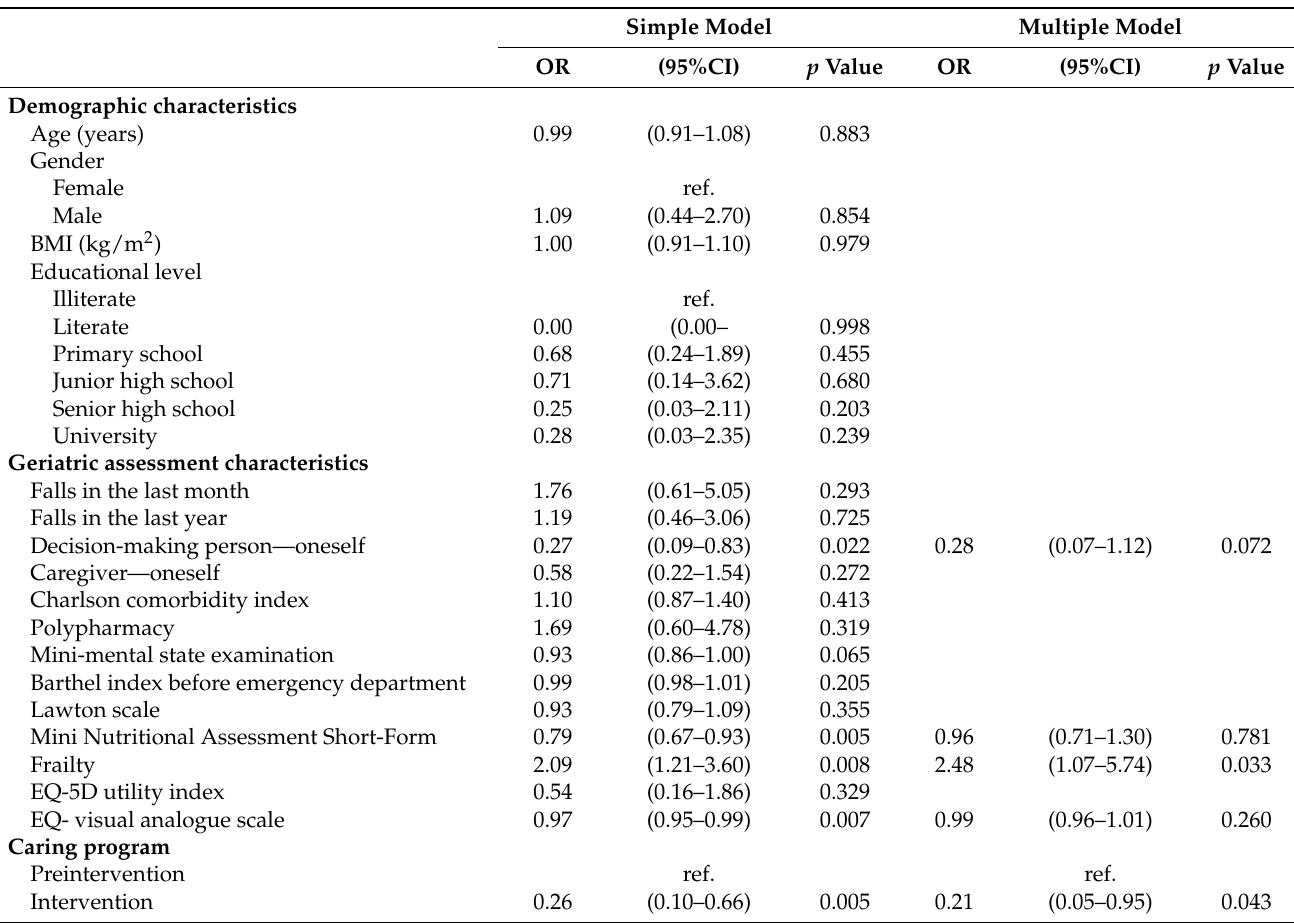
Table 6. Predictors of death within three months after index ED